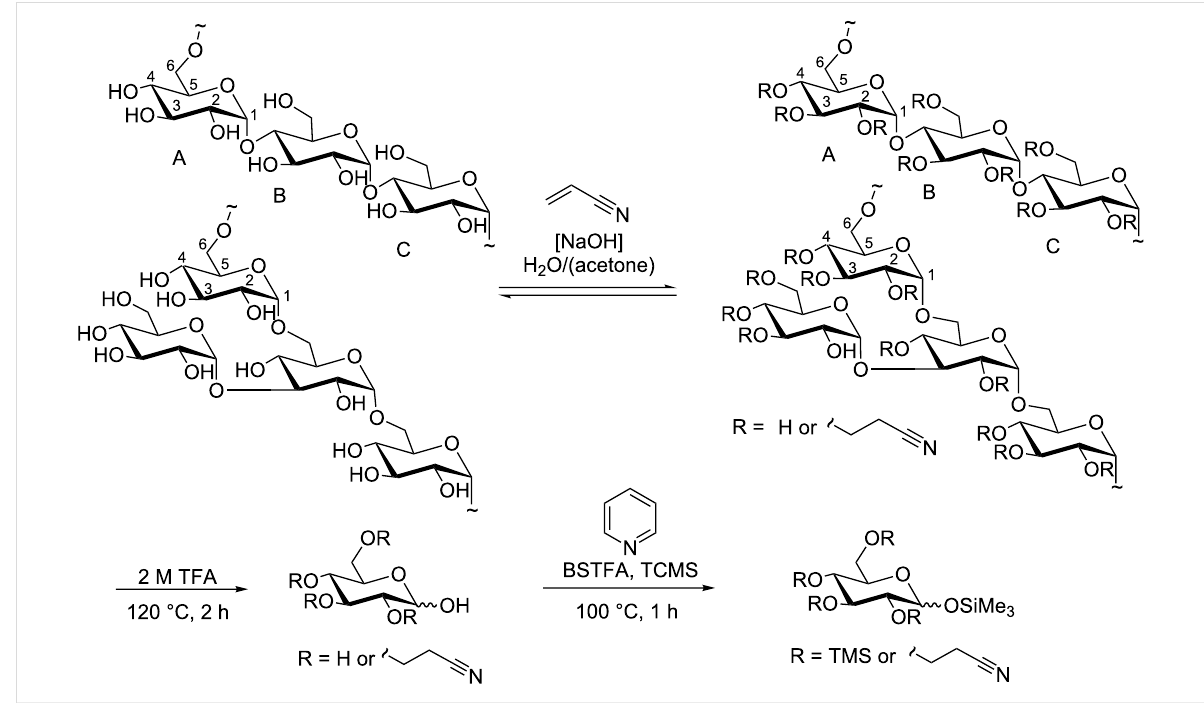
Figure 1: Polysaccharide structures of pullulan and dextran cyanoethylation with acrylonitrile and NaOH as catalyst; sample preparation for GLC/ GLC–MS analysis: depolymerization and silylation.